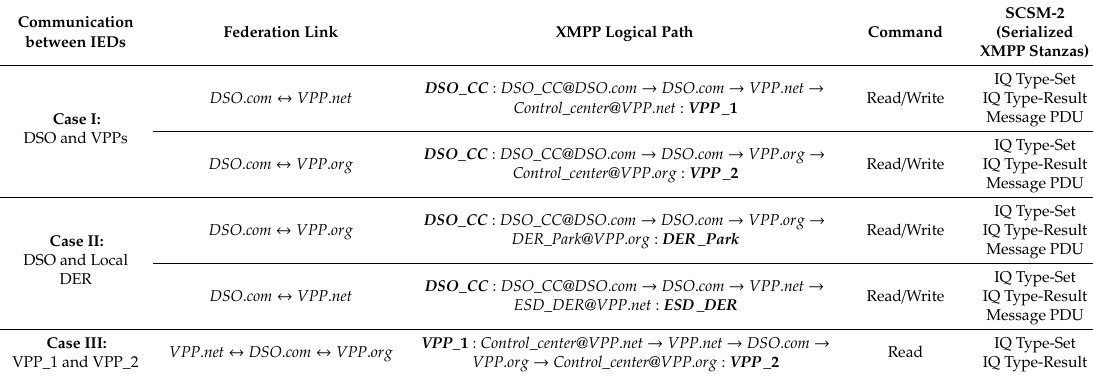
Table 3. Federation-based message exchanges in multiple JID